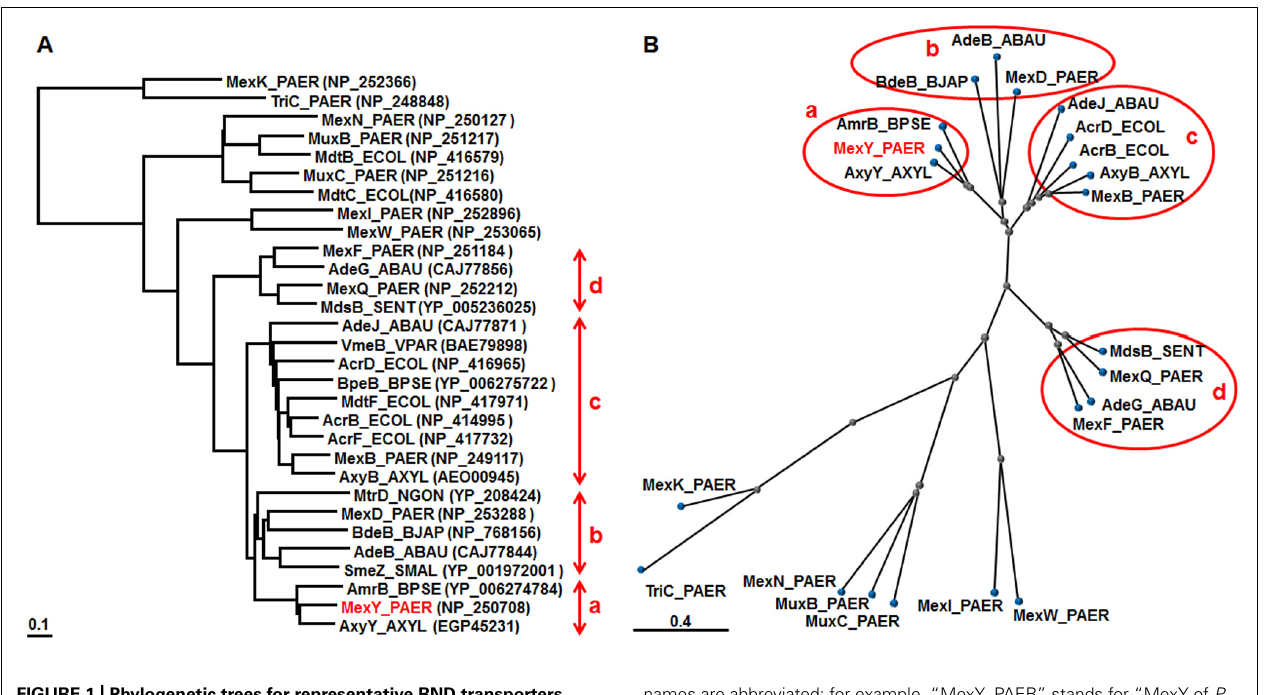
FIGURE 1 | Phylogenetic trees for representative RND transporters. According to the COBALT program, the trees were constructed using the Fast evolution method and rendered with (A) Rectangle and (B) Radical. Protein